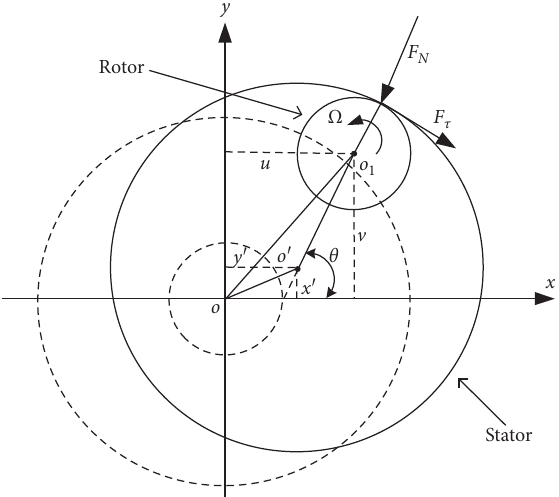
Figure 3: Schematic diagram of rub-impact